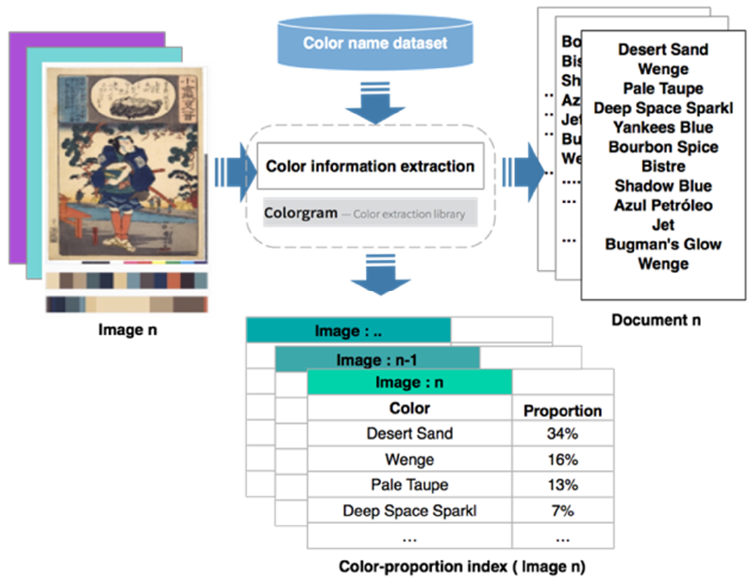
Figure 10. Extracting the color-proportion index and a color description document from the image data. In the color description document, the name of each color is treated as a word unit.